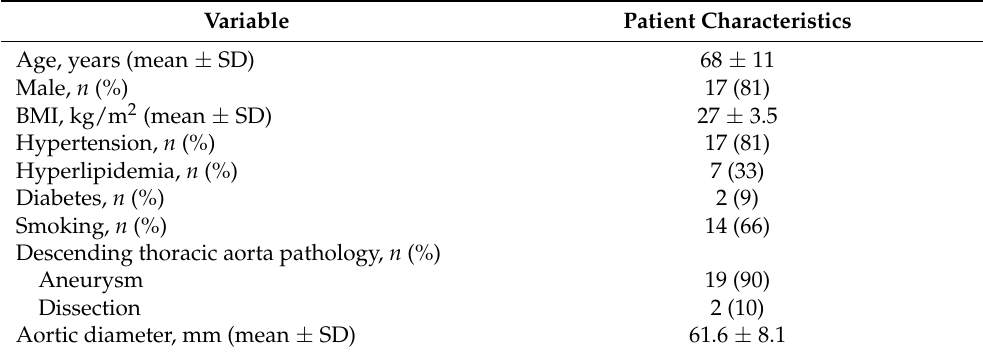
Table 1. Population characteristics ( n =